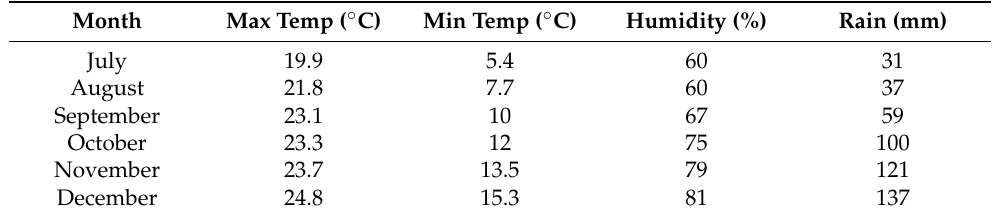
Table 5. Monthly weather data during the field trial at Ukulinga Research Farm, Pietermaritzburg, South Africa (2020). Month Max Temp ( ◦ C) Min Temp ( ◦ C) Humidity (%) Rain